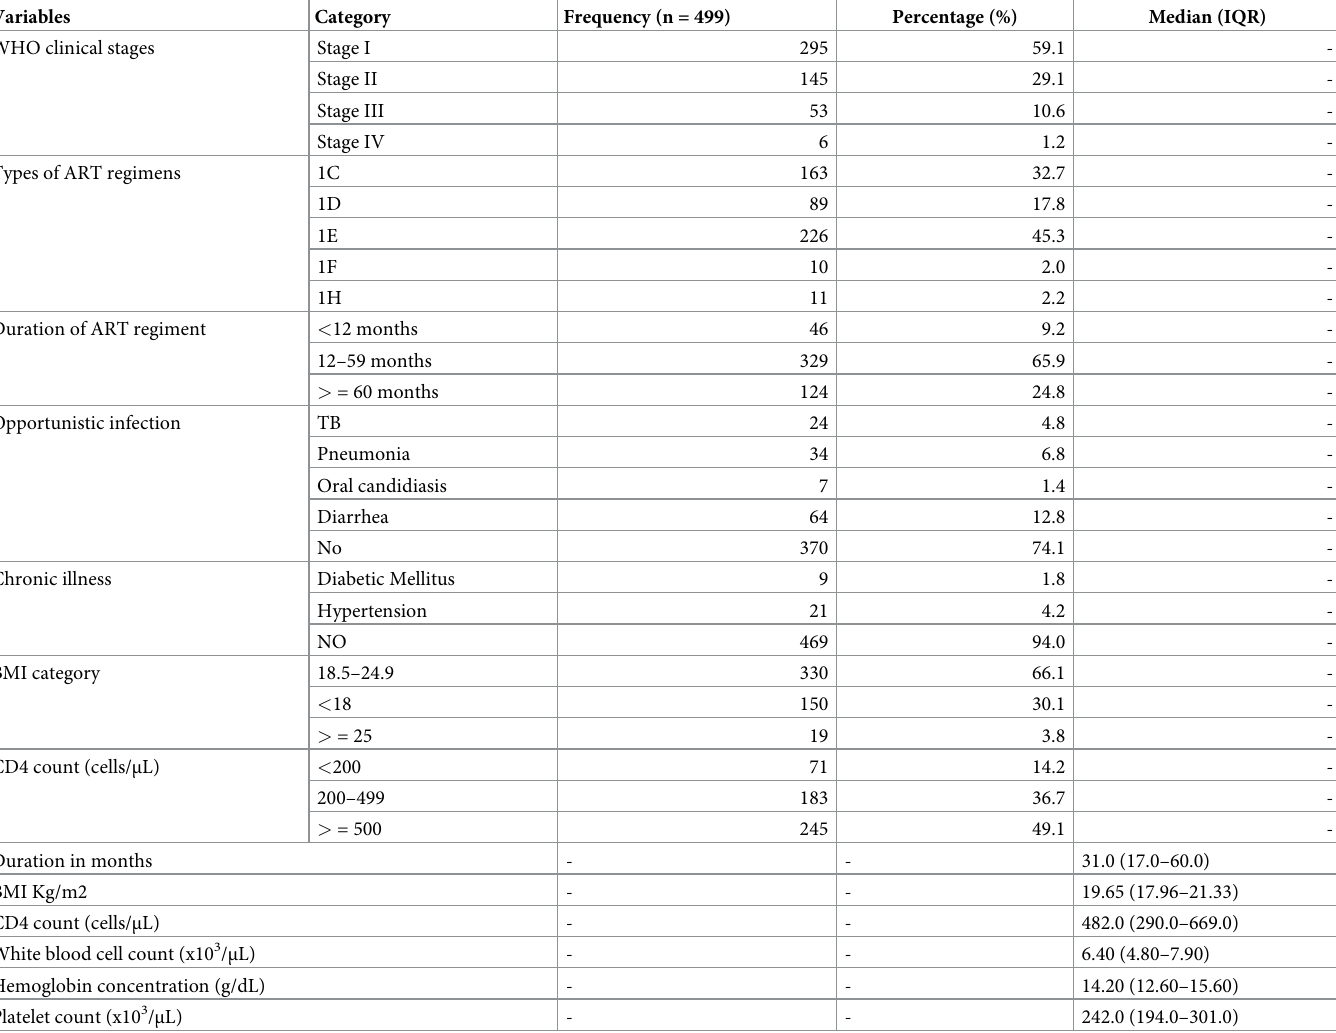
Table 2. Clinical and laboratory characteristics of HIV infected patients on HAART at Mahal-Meda Hospitals, Northern Shewa Zone, Ethiopia, 2018 (n =